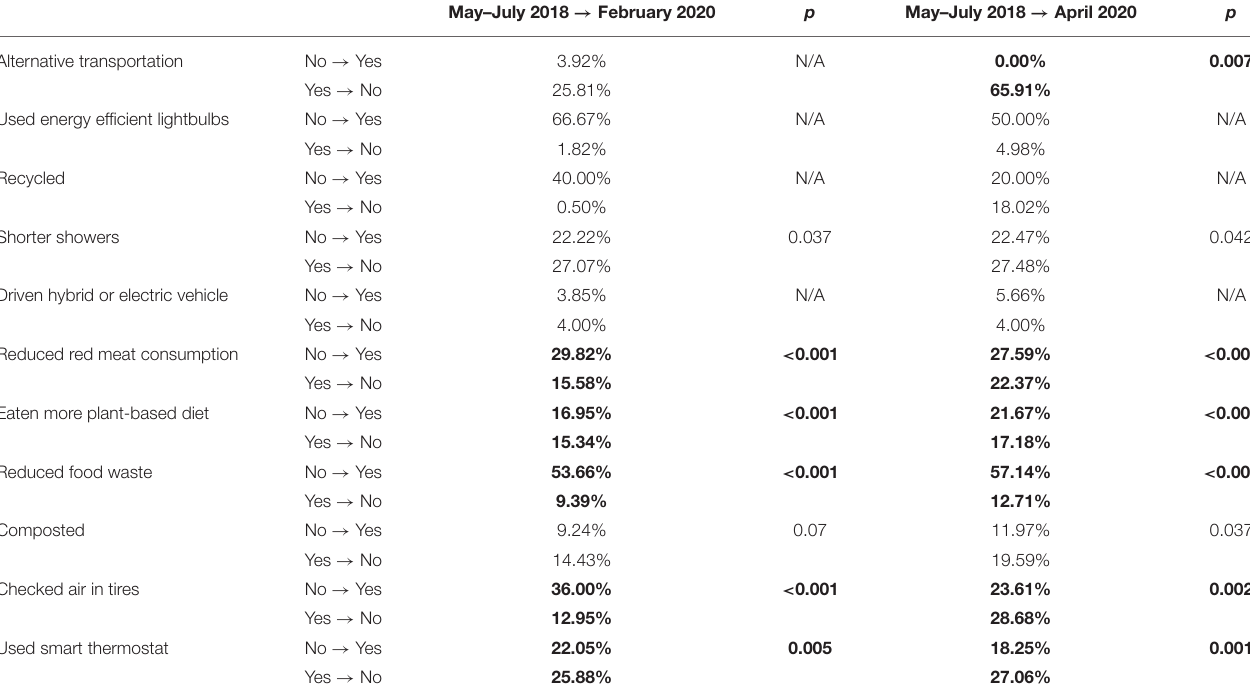
TABLE 2 | Ratios of response changes in matched sample ( n =